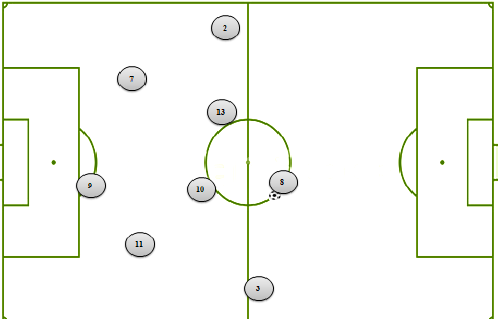
Figure 3. Recall–reconstruction test (immediate or delayed) used for the complex multimedia ma-